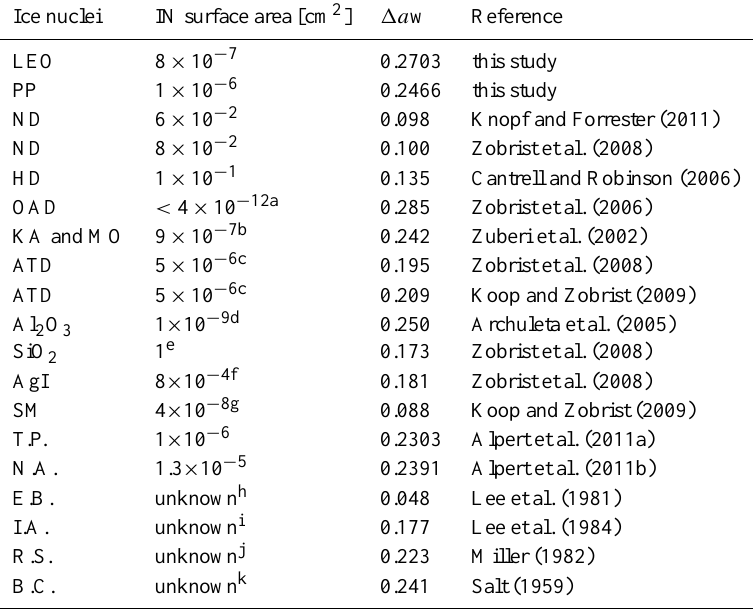
Table 6. Water activity shift from the ice melting curve, 1a w , for various immersion ice nuclei in different aqueous solutions. Approximate estimates of the ice nucleus surface area (order of magnitude) are also given for comparison. LEO: leonardite, PP: Pahokee Peat, ND: 1-nonadecanol, HD: 1-heptadecanol, OAD: oxalic acid dihydrate, KA: kaolinite, MO: montmorillonite, ATD: Arizona test dust, Al 2 O 3 : aluminum oxide, AgI: silver iodide, SiO 2 : silica spheres, SM: Snowmax, T.P.: Thalassiosira pseudonana , N.A.: Nannochloris atomus ,